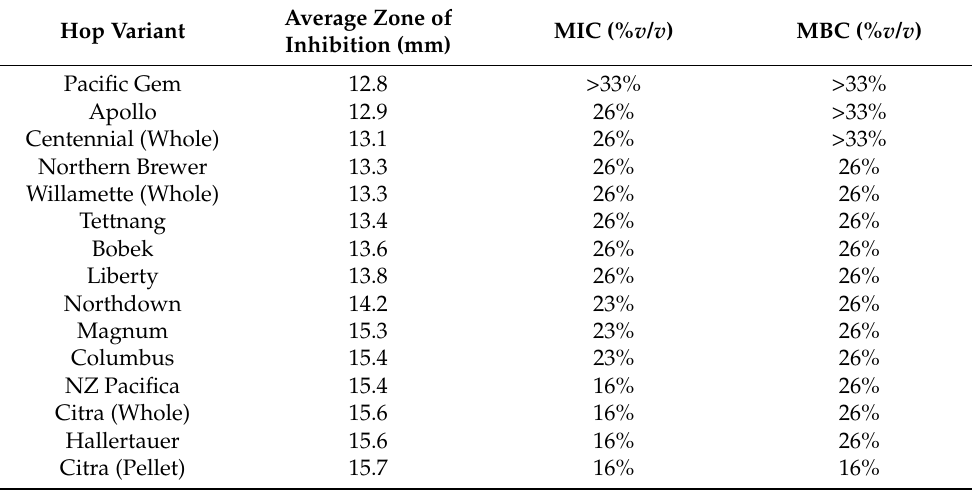
Table 3. The MIC and MBC (% v / v ) of 14 hop variants against M. bovis BCG as determined by the agar incorporation assay. All other hop variants exhibited a similar profile to ‘Pacific Gem’ with an MIC and MBC exceeding